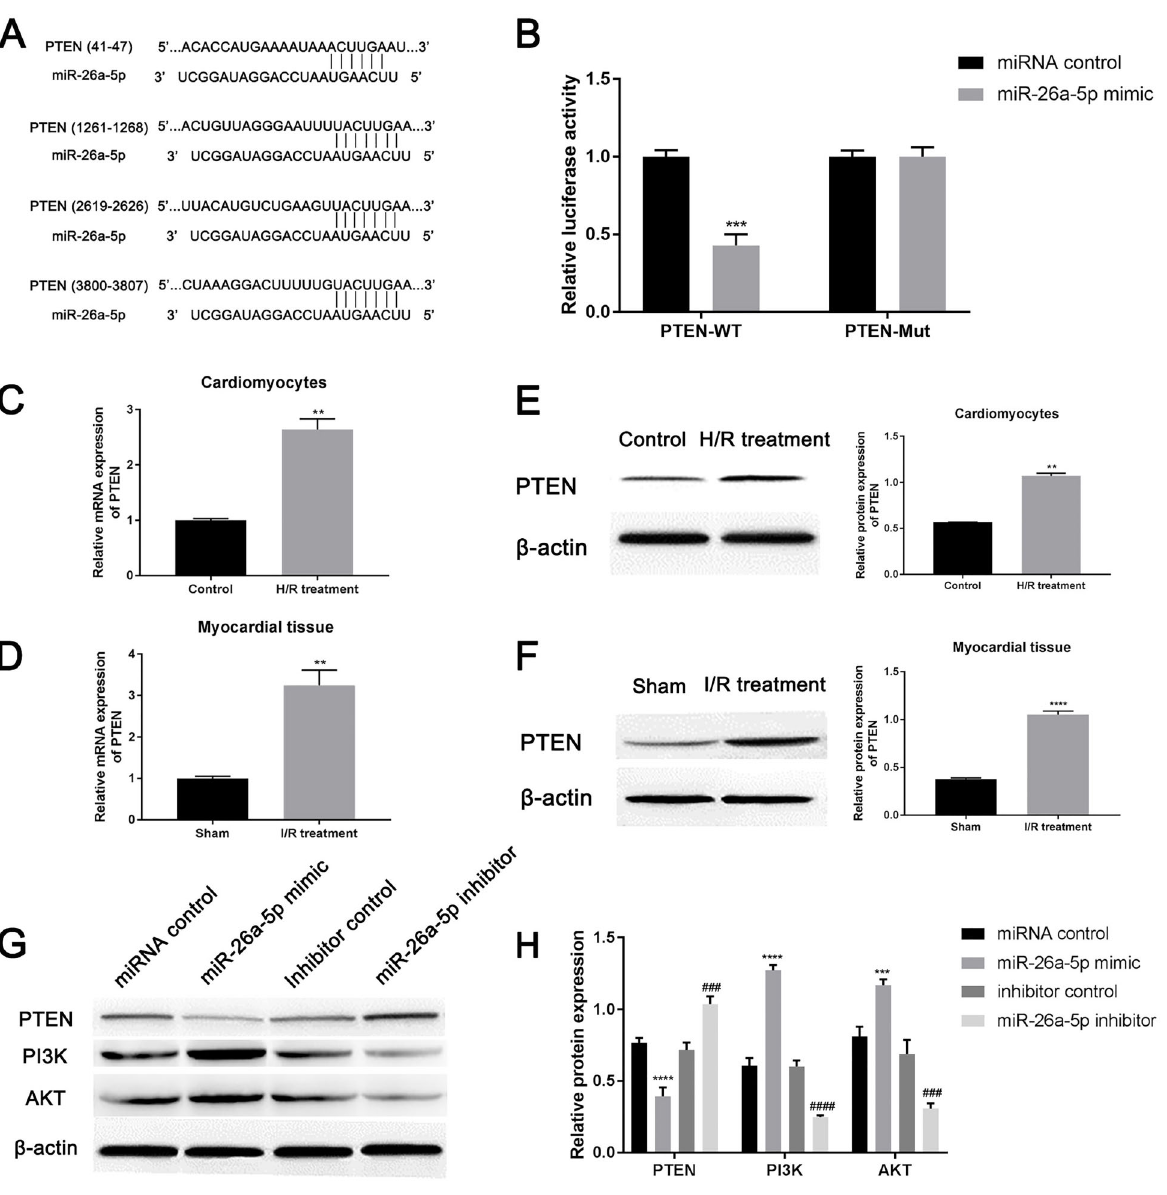
Figure 4. Interaction between miR-26a-5p and PTEN. A , Binding sites between miR-26a-5p and PTEN. B , Luciferase reporter assay measured the luciferase activity of PTEN-WT (wild type) or PTEN-Mut (mutant) vector. The mRNA and protein expression of PTEN in ( C and E ) cardiomyocytes after hypoxia/reoxygenation (H/R) and ( D and F ) myocardial tissue upon ischemia/reperfusion (I/R) injury was measured by qRT-PCR and western blot, respectively. After transfection of four different miR-26a-5p vectors, the expression of PTEN, PI3K, and AKT was evaluated by ( G ) western blot and quanti fi ed by ( H ) ImageJ software. Data are reported as means ± SD. **P o 0.01, ***P o 0.001, ****P o 0.0001 vs control groups; ### P o 0.001, #### P o 0.0001 vs inhibitor control ( t -test or